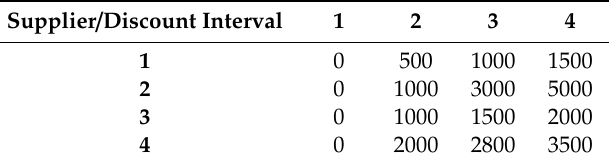
Table 7. Price discount interval lower limits ( K ik ).